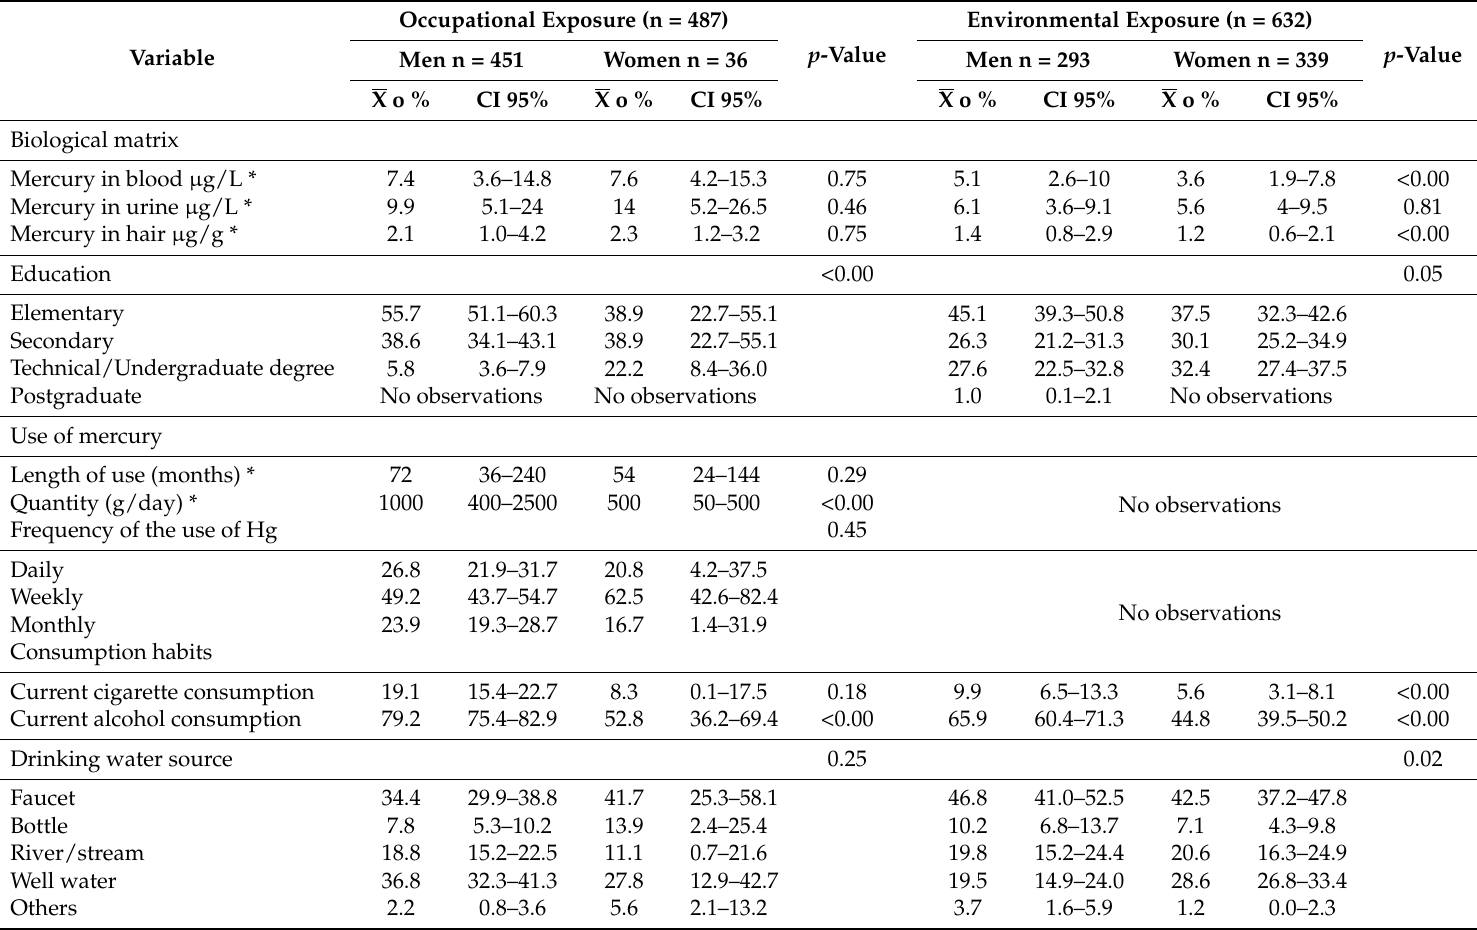
Table 2. Characteristics of the participants according to type of exposure and sex in the La Mojana region,